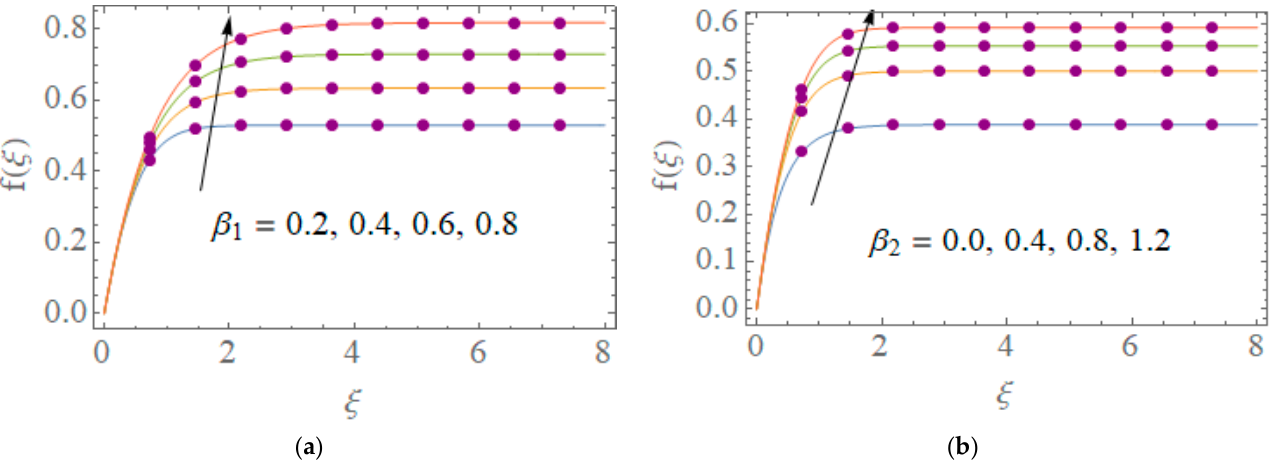
Figure 11. Assessment of TLM-BANN for ϕ with reference dataset of TD-PNFM. ( a ) Variation of β 1 for ϕ ; ( b ) AE analysis in variation of β 1 for ϕ ; ( c ) Variation of β 2 for ϕ ; ( d ) AE analysis in variation of β 2 for ϕ ; ( e ) Variation of α for ϕ ; ( f ) AE analysis in variation of α for ϕ ; ( g ) Variation of N t for ϕ ; ( h ) AE analysis in variation of N t for ϕ .